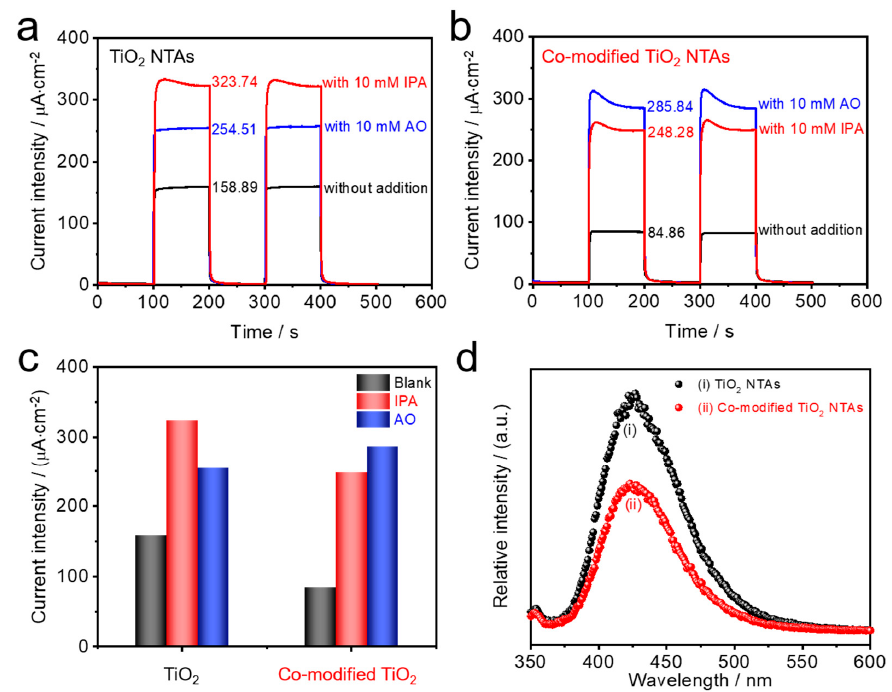
Figure 4. ( a – c ) Photocurrent of TiO 2 and the co-modified TiO 2 NTAs in PBS with capture agent added separately. ( d ) Photoluminescence pattern of terephthalic acid irradiated with ultraviolet